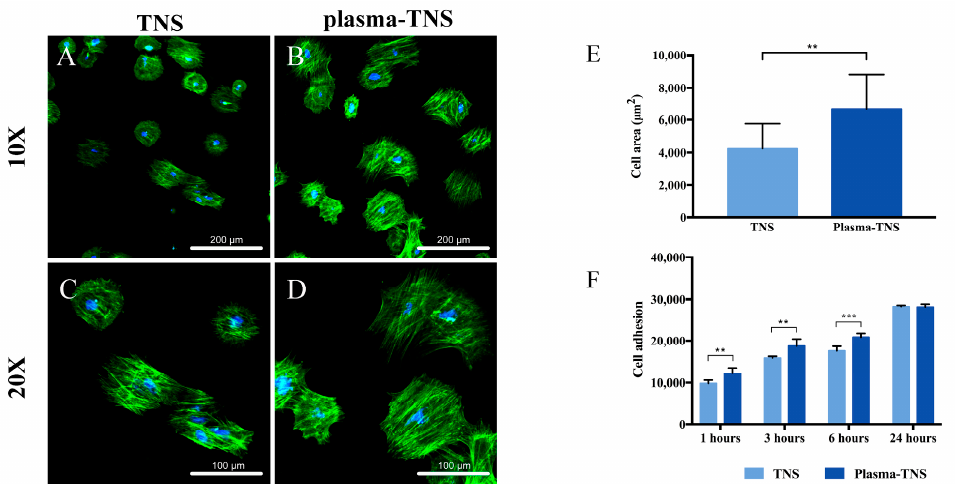
Figure 5. Morphological analysis of rBMMSCs attached to the ( A , C ) TNS and ( B , D ) plasma-TNS disks, ( E ) cell area, values were presented as mean ±SD of three representative images measured as per the surface of three samples in each group, ( F ) cell adhesion on TNS and plasma-TNS disks at 37 °C. Data shown are the means ±SD ( n = 3). *** p < 0.001; ** p < 0.01.